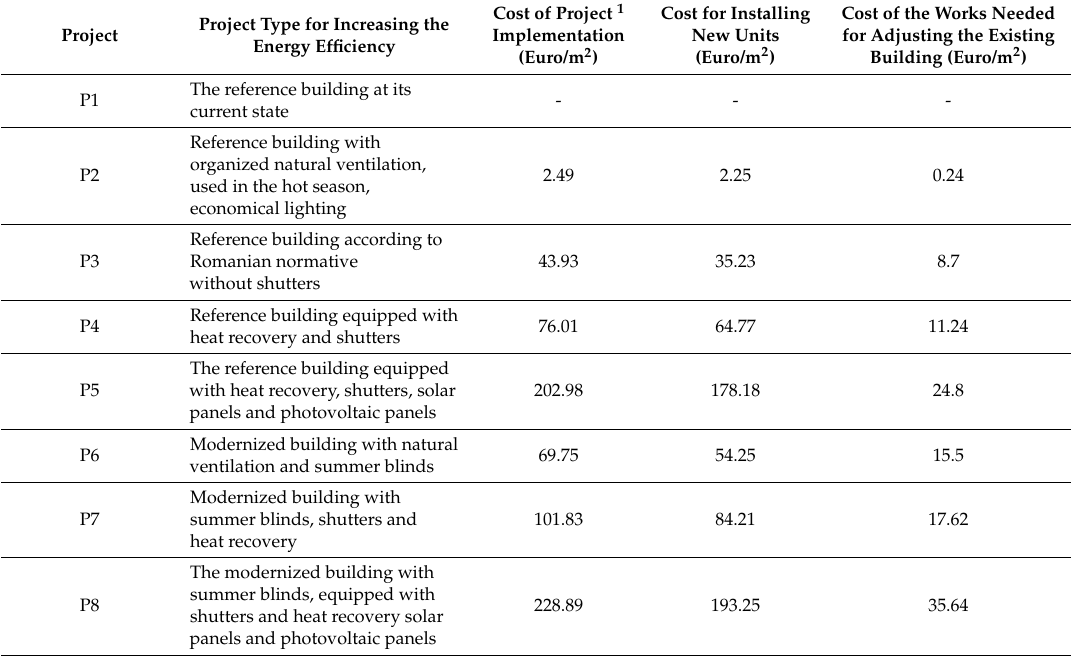
Table 2. The cost of implementing projects to increase energy